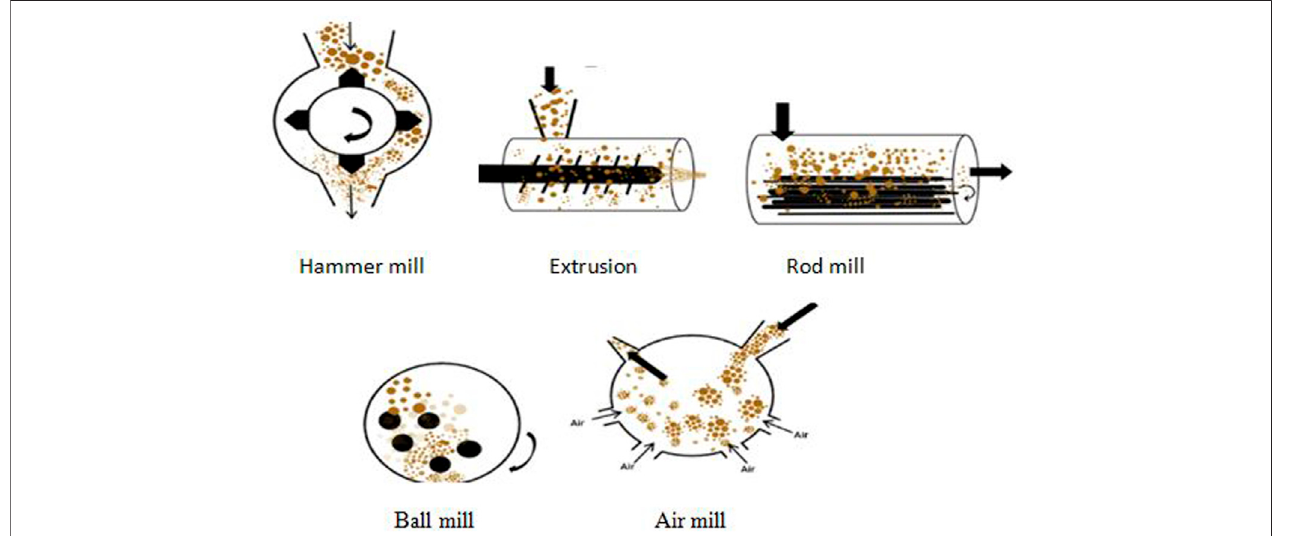
TABLE 2 | Pretreatment processes (Kumar and Wyman, 2009; Karmakar, 1999; Müller, 2001; Müller et al., 2004). Processes Merits Demerits Mechanical Depletes the crystalline structure of cellulose High power consumption rate comminution Hydrolysis using acids